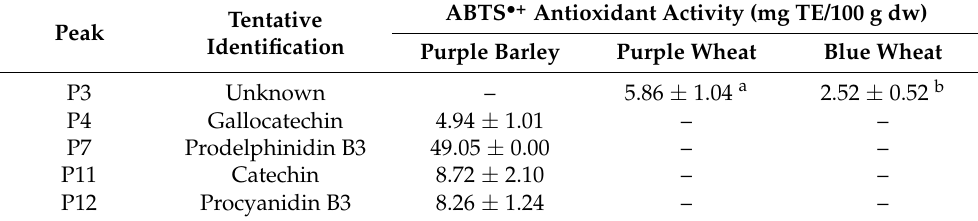
Table 2. Comparison of Online ABTS • + antioxidant activity (414 nm) in pigmented barley and wheat methanol extracts.